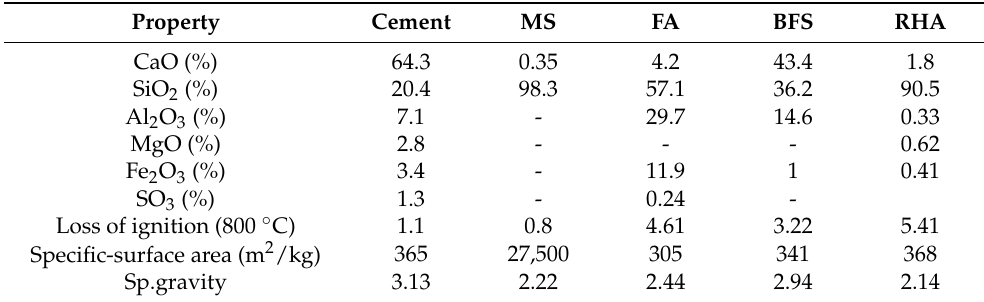
Table 1. Properties of waste mineral admixtures (MS, FA, BFS, and RHA) and cement.